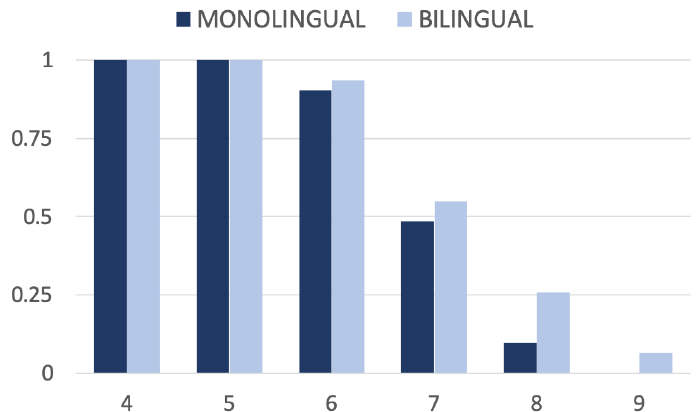
Figure 5. Digit span task: proportion of group who reached each list